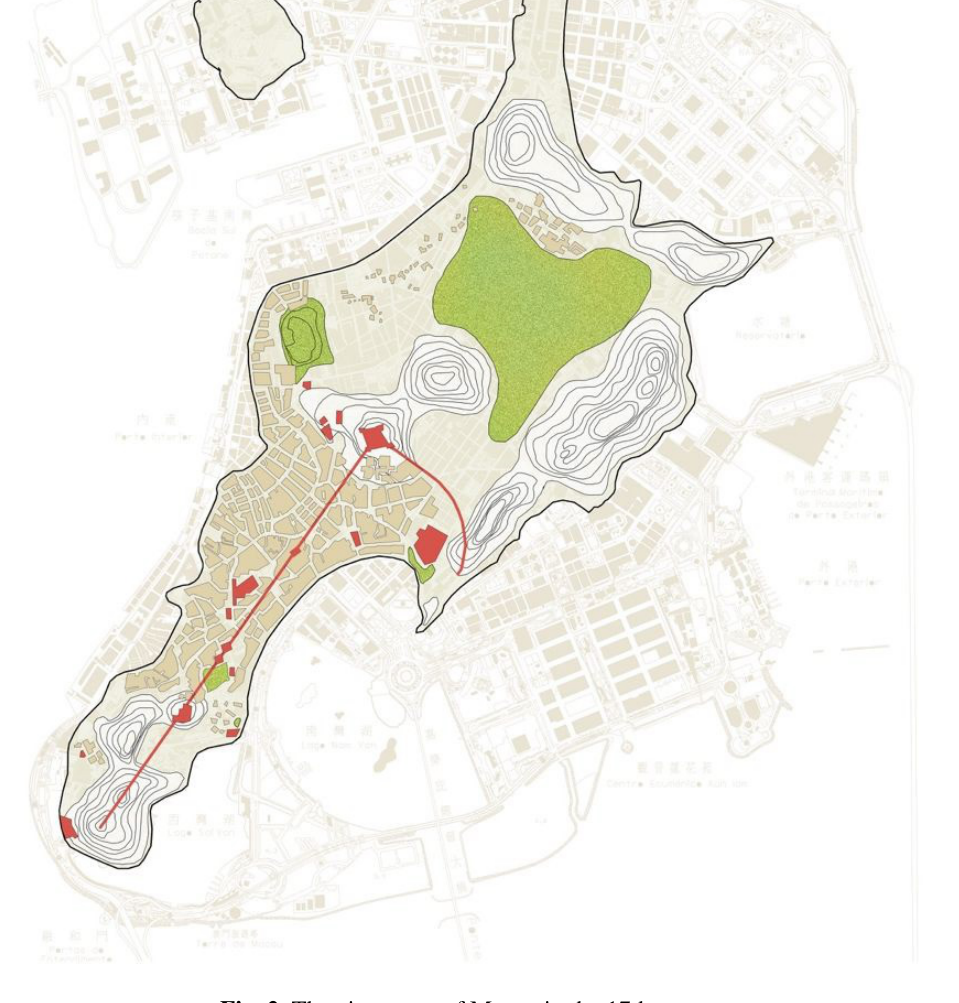
Fig. 2 The city scope of Macau in the 17th